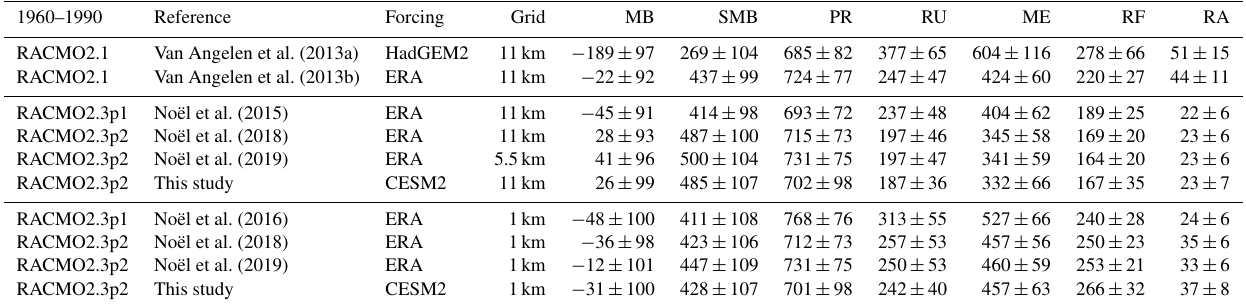
Table 1. Annual mean SMB and components integrated over the GrIS (Gtyr − 1 ) for the period 1972–1990 from an ensemble of RACMO2 simulations using various spatial resolutions and lateral forcing. SMB components include total precipitation (PR), runoff (RU), melt (ME), refreezing (RF) and rainfall (RA). The uncertainty range corresponds to 1 standard deviation around the mean. Here mass balance of the GrIS (MB) is estimated as GrIS-integrated SMB minus glacial discharge for the period 1972–1990 (458Gtyr − 1 ) (Mouginot et al., 2019).